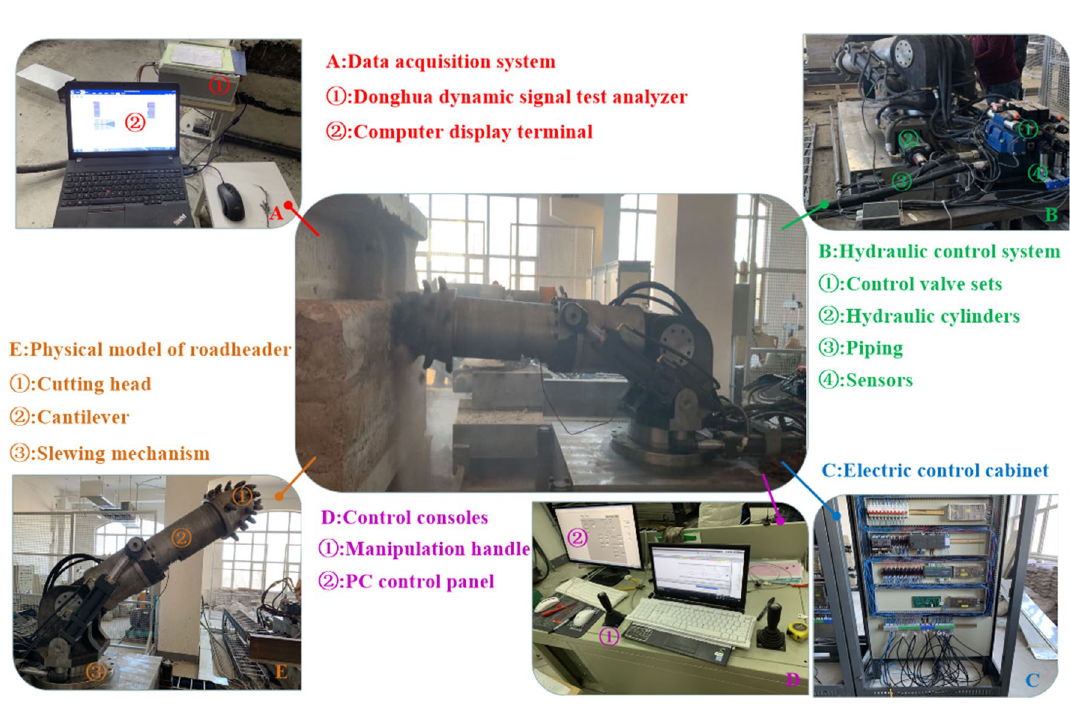
Figure 12. Cutting test